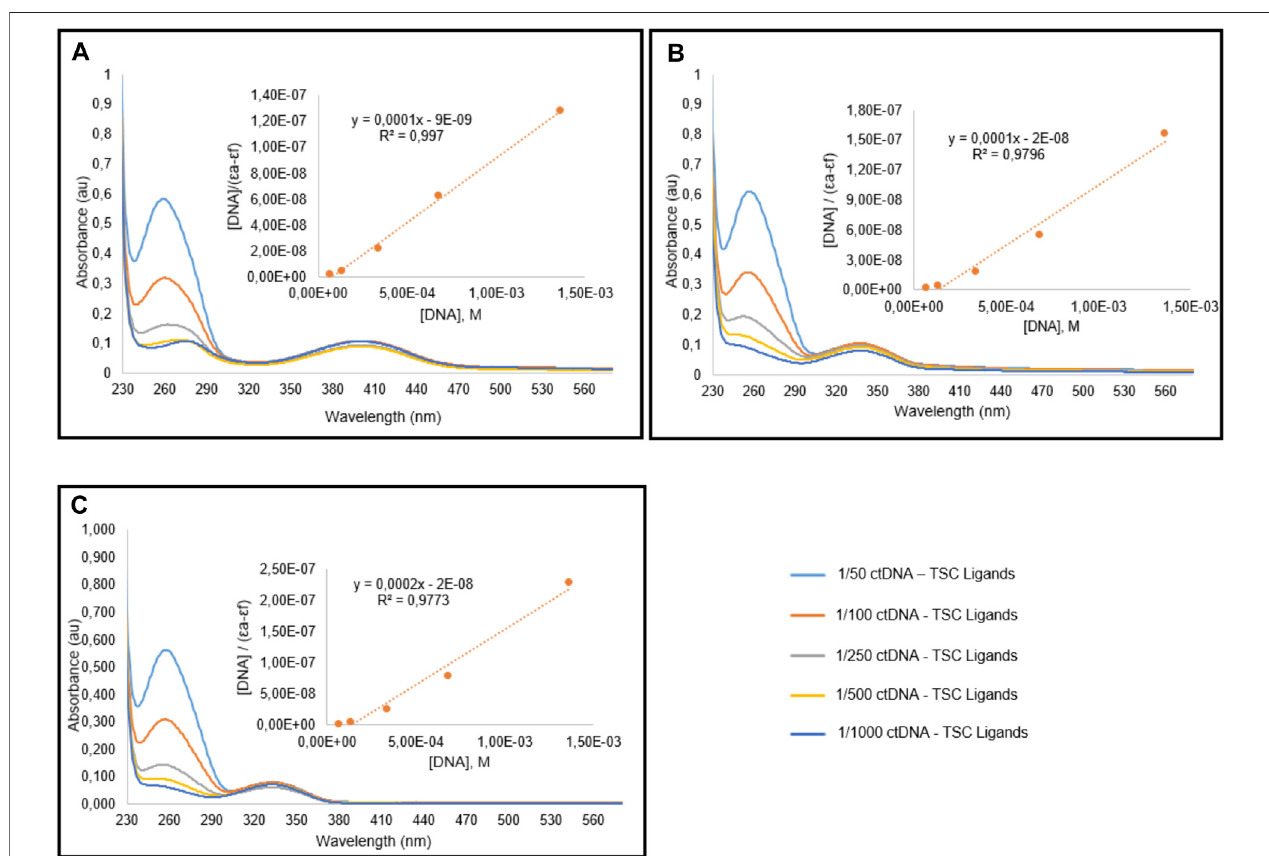
FIGURE 4 | Spectral graphic of TSC ligands L1 (A) , L2 (B) , L3 (C) in the presence of CT-DNA. Ligands concentration is 10 μ M, and DNA concentration is variying between 0.07 and 1.4 mM.